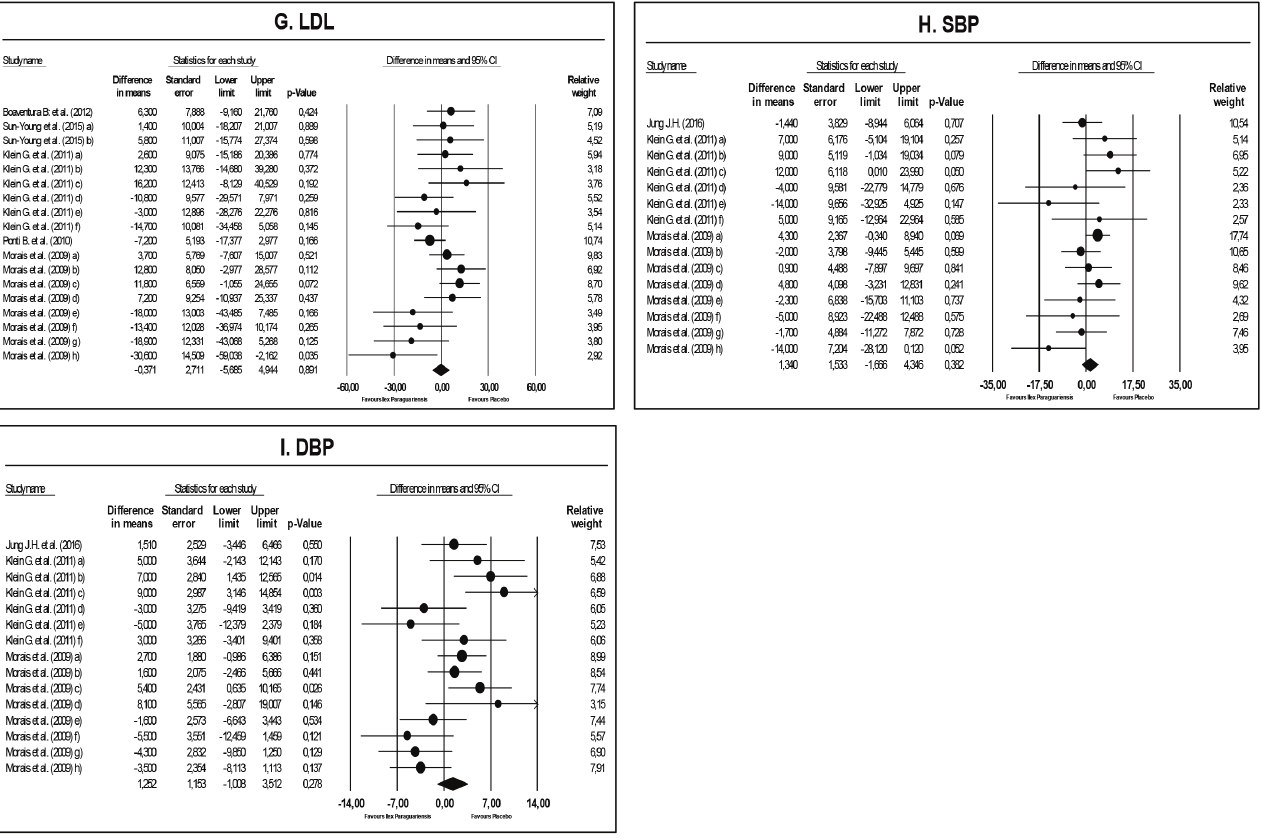
FIGURE 3 (cont.) - Forest plots of comparisons of the effects I. paraguariensis consumption on the outcomes of this meta-analysis, compared with control arms. BMI – body mass index; DBP – diastolic blood pressure; HDL – HDL-cholesterol; LDL – LDL- cholesterol; SBP – systolic blood pressure; TC – total cholesterol; TG –